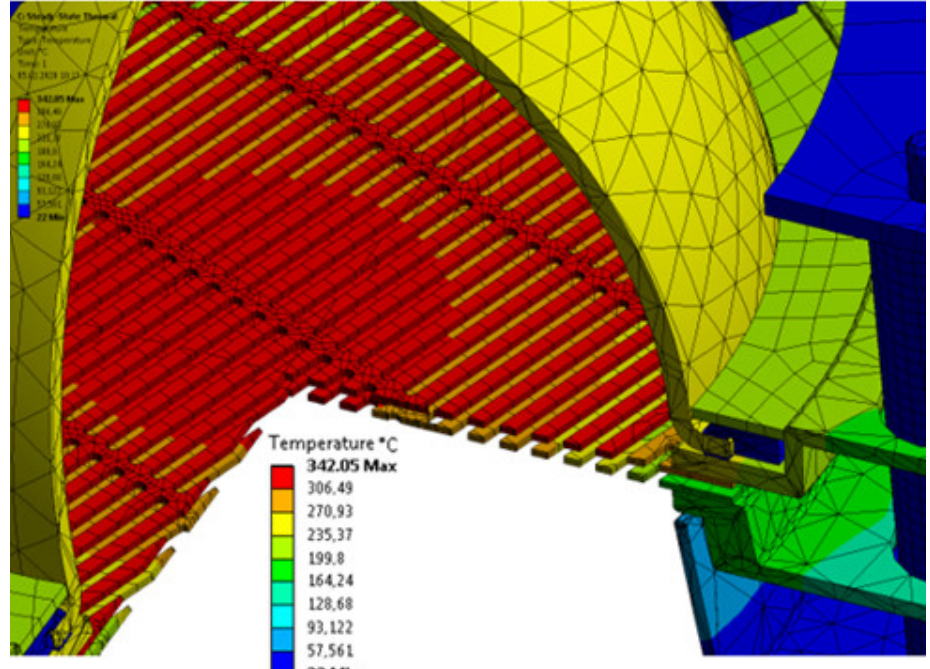
Figure 4. Predicted temperature patterns in the IS from the GDC end (sectional view).